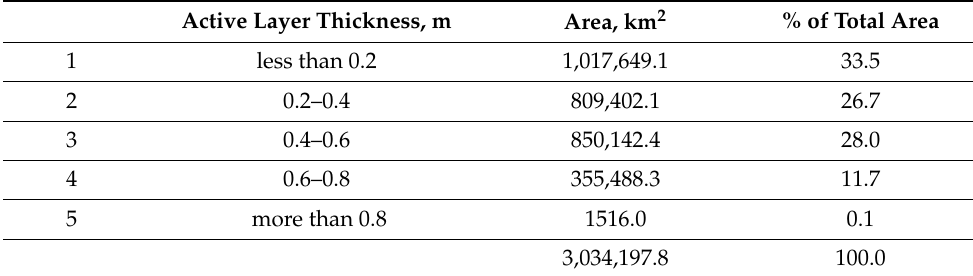
Table 3. Spatial distribution of ground ice